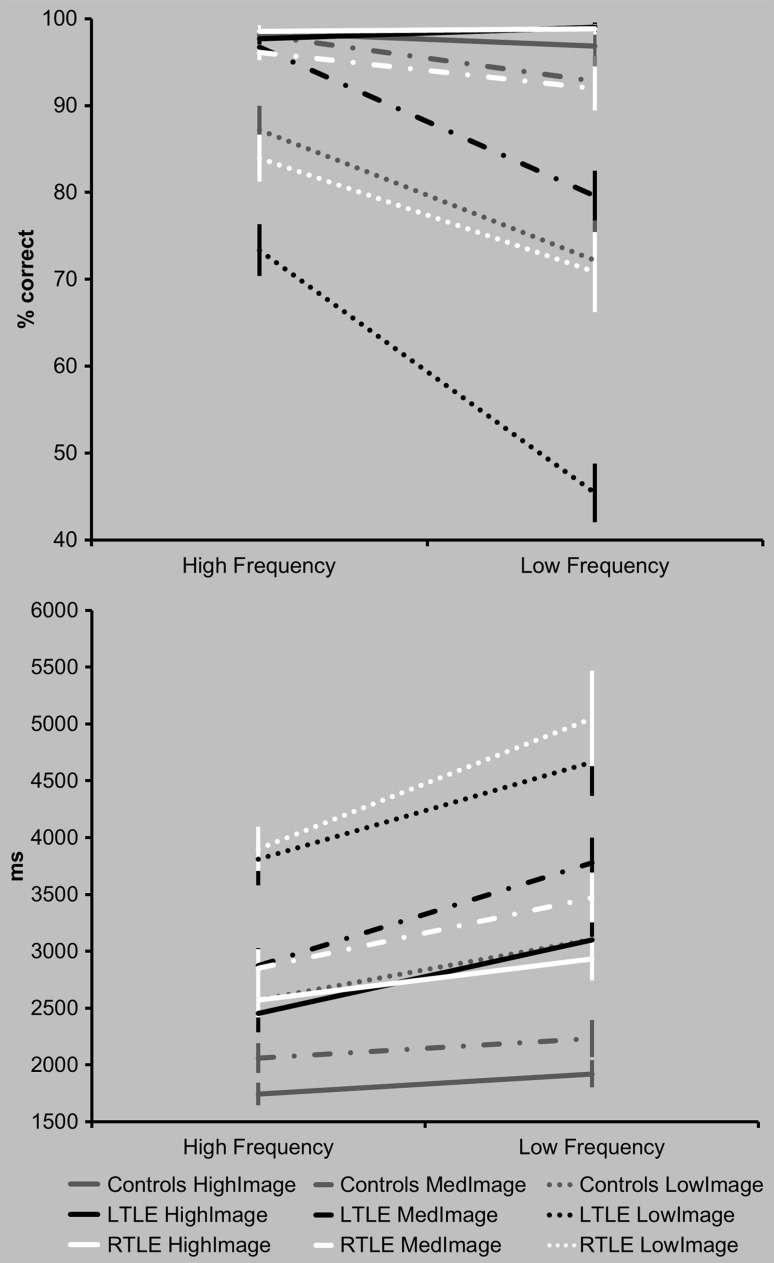
Synonym judgment frequency × imageability analysis. Breaking down performance on the synonym judgment task by frequency (high, low) and imageability (high, medium, low). The color of the line denotes the group (controls, grey; left TLE, white; right TLE, black). The line style denotes the condition (solid line = high imageability, hashed line = medium imageability, dotted line = low imageability). Error bars denote standard error.